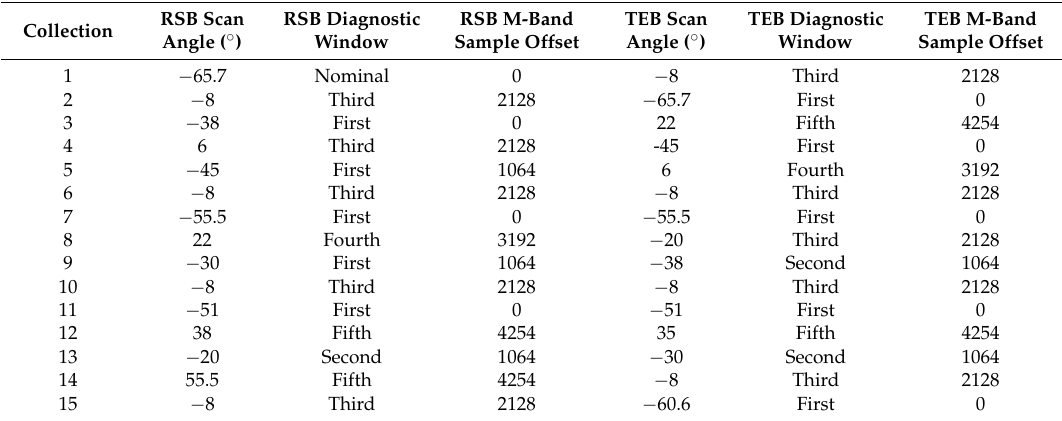
Table 3. Response Versus Scan (RVS) Data Collection Configuration with Scan Angles and Diagnostic Window Information for both the Reflective Solar Bands (RSBs) and Thermal Emissive Bands